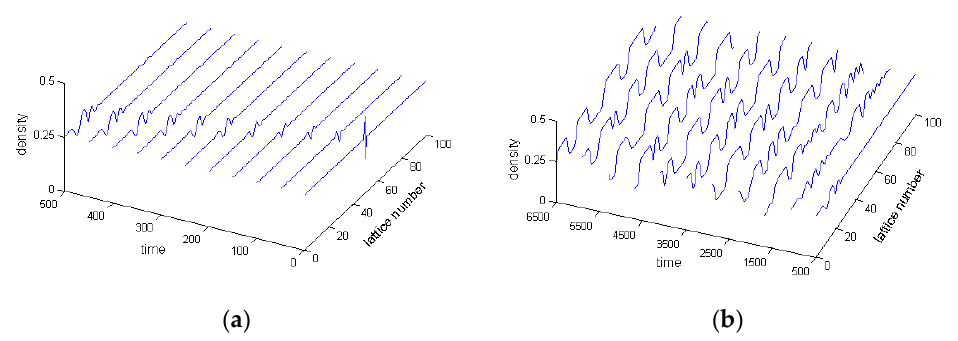
Figure 1. Traffic wave-developing process of the new model